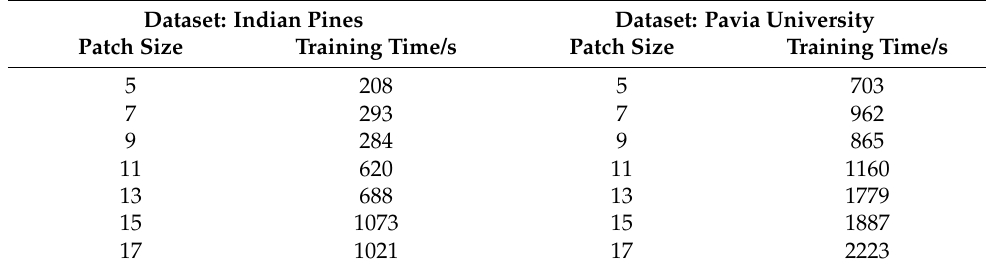
Table 2. Training time for seven patch sizes for the two datasets. Dataset: Indian